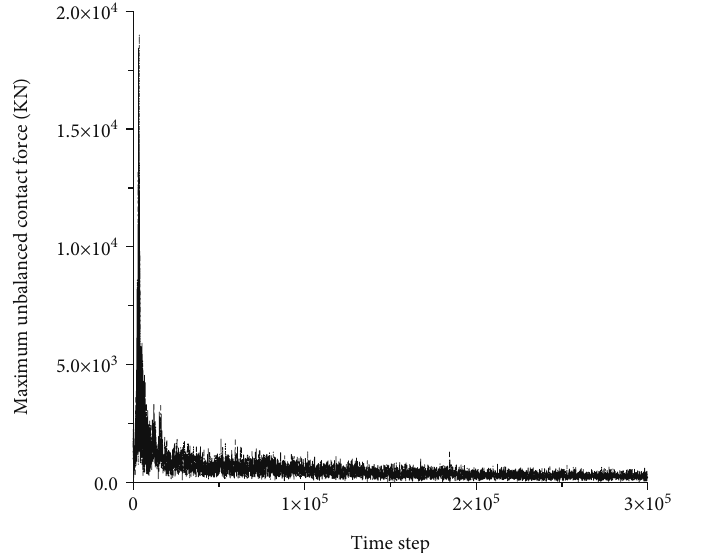
Figure 6: Diagram of maximum unbalance forces during particle equilibrium.